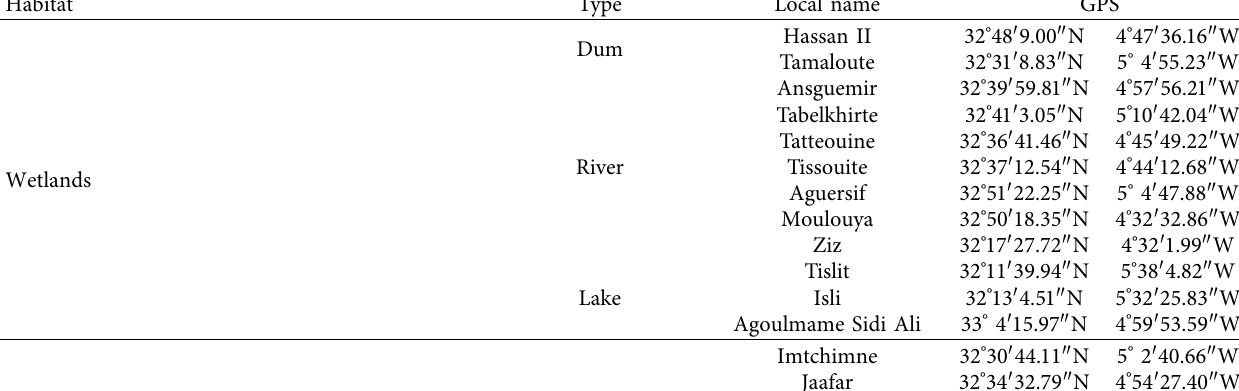
Table 2: Type and localisation of studied habitats in the Midelt region, Morocco.